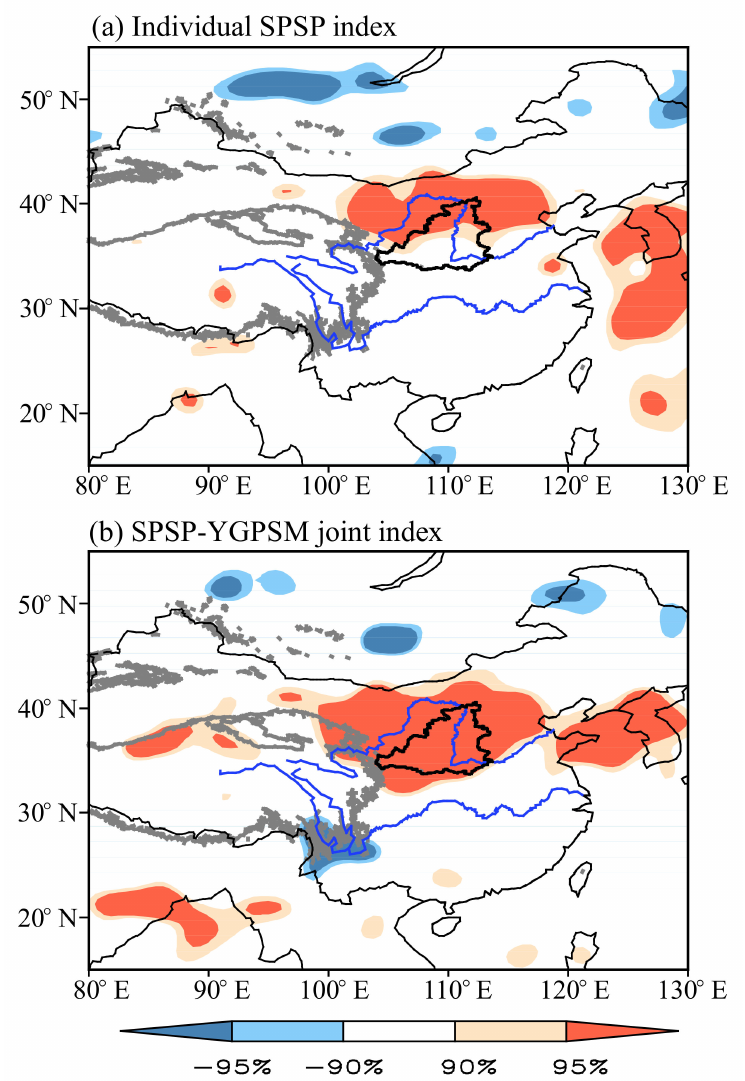
Figure 10. ( a ) Distribution of correlation coefficients between the July–August individual SPSP index and September precipitation during the period 1979–2021; ( b ) As in ( a ), but for that between the July–August SPSP-YGPSM joint index and September precipitation. Shadings denote the correlation significant at the 90 and 95% confidence levels, as shown by the color bars. The black bold borderline around the Yellow River (the blue curve in northern China) represents the MRYR region and the thick gray contour denotes the Tibetan Plateau (3000 m above sea